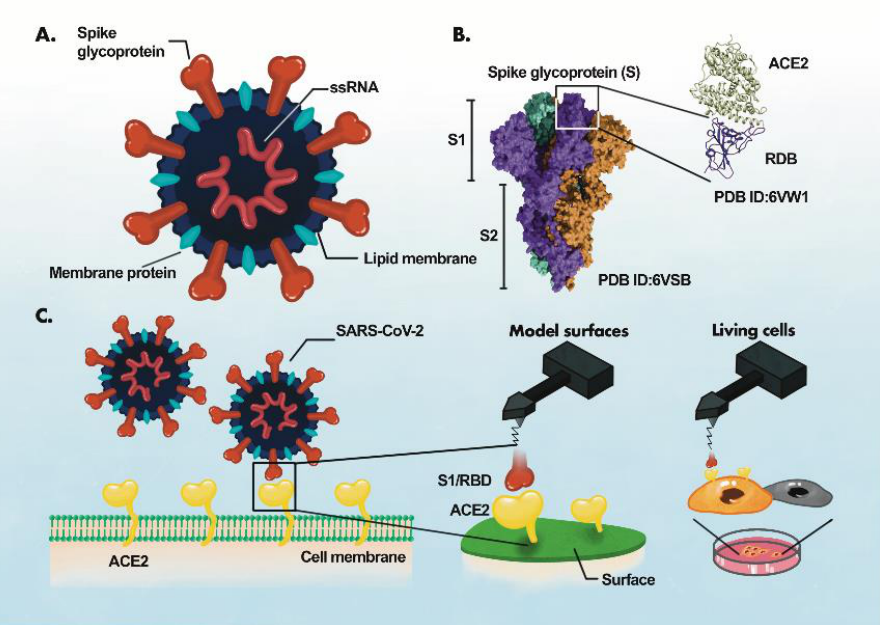
Figure 3. AFM study of ACE2-S- protein binding mechanism. ( A ), Components of the virus particle. ( B ), Complex between receptor-binding domain (RBD) of SARS-CoV-2 and ACE2. ( C ), Atomic force microscopy (AFM) study of the ACE2 binding with RBD. The ACE2 receptor is immobilized on a surface and S1 subunit or RBD is attached to the surface of the AFM tip. Adaptede from Ref. [39]